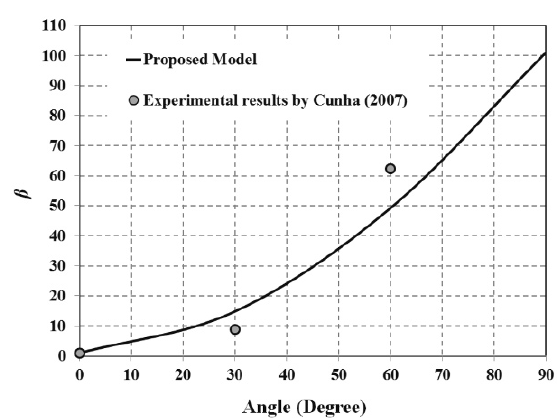
Figure 11. Comparison of the predicted curve for β by Equation (10) with the experimentally obtained U peak ( φ ) / U peak (0) ratios for different inclination